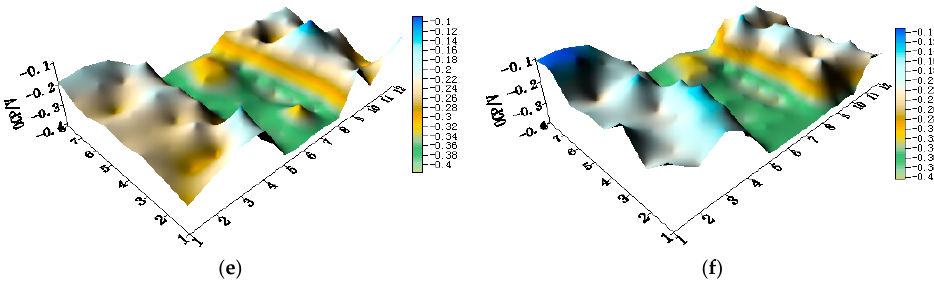
Figure 11. Potential distribution maps of CMEA3 at OCP (V/SCE) after immersion in artificial seawater with different concentrations of chloride ions (wt %): ( a ) 1.5%; ( b ) 1.7%; ( c ) 1.9%; ( d ) 2.1%; ( e ) 2.3%; and ( f ) 2.5%.